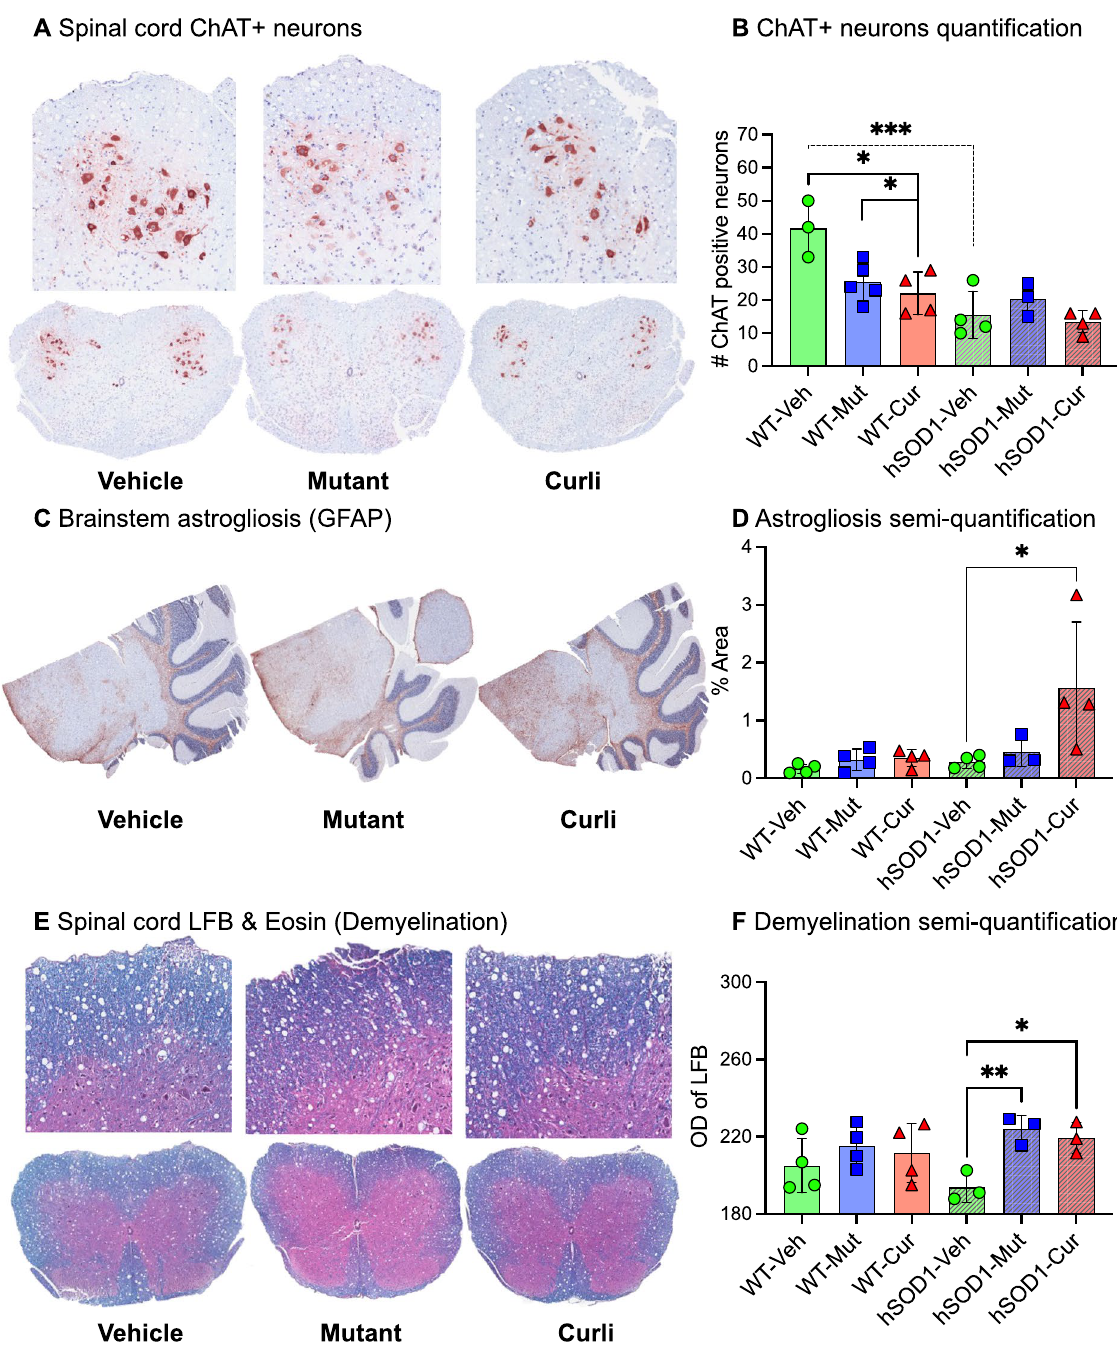
Figure 5. Neurodegeneration, inflammation, and demyelination in the nervous system. ( A , B ) Within the male WT group, mutant and curli-fed mice showed significantly decreased cholinergic (ChAT+) neurons compared to vehicle. Within the vehicle group, hSOD1 males had fewer ChAT+ neurons compared to WT controls. ( C , D ) Within the male hSOD1 cohort, curli-fed mice showed increased astrogliosis in brainstem compared to vehicle. Images were quantified in ImageJ utilizing percent positive signal of staining. ( E , F ) Within the male hSOD1 cohort, mutant and curli-fed mice showed significant demyelination in white matter of spinal cords compared to vehicle groups (encroachment of pink cytoplasmic stain eosin into areas of Luxol Fast Blue stained myelin). * p < 0.05, ** p < 0.01, *** p < 0.001, one-way ANOVA. n = 3–5 per